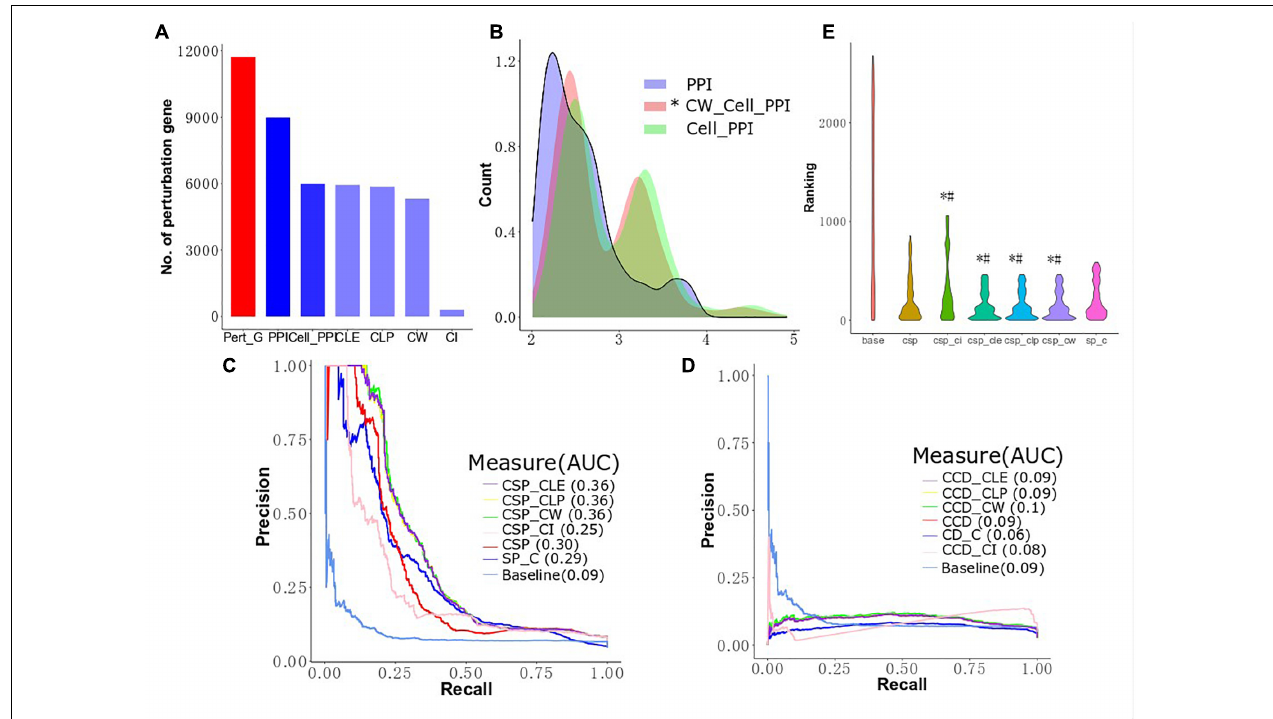
FIGURE 5 | Cluster improving the performance of target prioritization. (A) The number of perturbed genes in MCF-7 cell lines after filtering by differential conditions. (B) Differentially expressed genes in clusters of cell PPI network are closer to known targets. The distributions of CW cell PPI are statistically different with PPI and cell PPI (Mann–Whitney, p -value < 2.2e − 16 and p -value = 3.804e − 05 , respectively). (C) Performance of target gene prioritization using local radiality among functional genes selection algorithms (CLE, CLP, CW, and CI). (D) Performance of target gene prioritization using correlation diffusion among functional genes selection algorithms (CLE, CLP, CW, and CI). (E) The predictions are given for the top 200 of the target gene ranking lists. # means the target ranking curve is significant different with the curve of human network based on Mann–Whitney test; ∗ means the target ranking curve is significant different with the curve of cell-based network based on Mann–Whitney